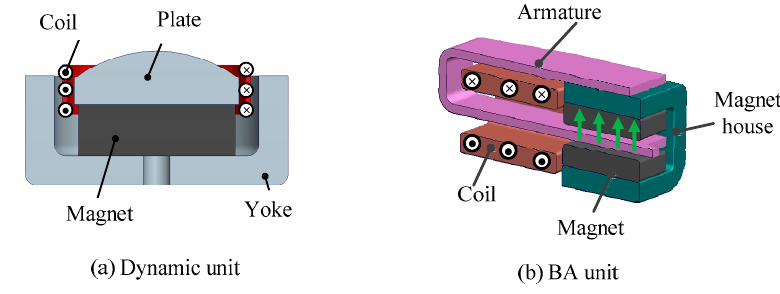
Figure 3. Electromagnetic domain boundary conditions.